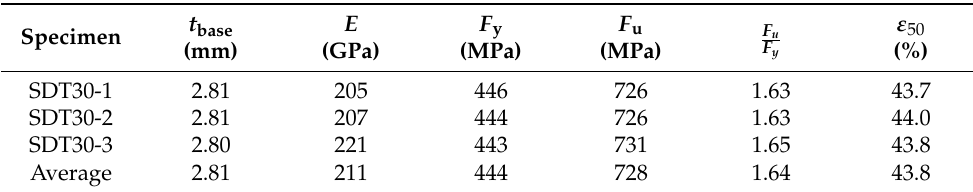
Table 1. Averaged material properties of lean duplex stainless steels.